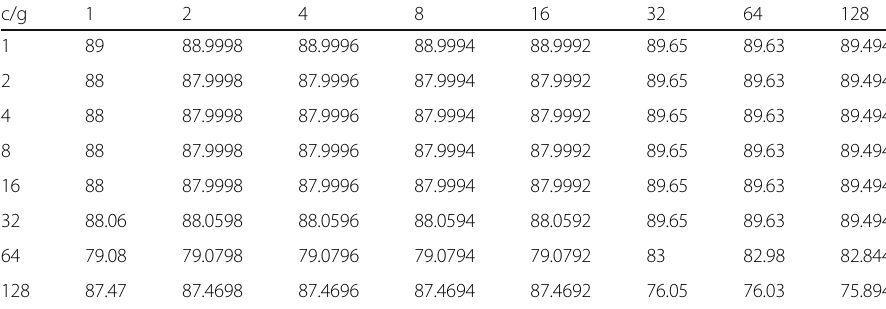
Table 4 DWSVM model mesh optimization algorithm _Acc value (%)